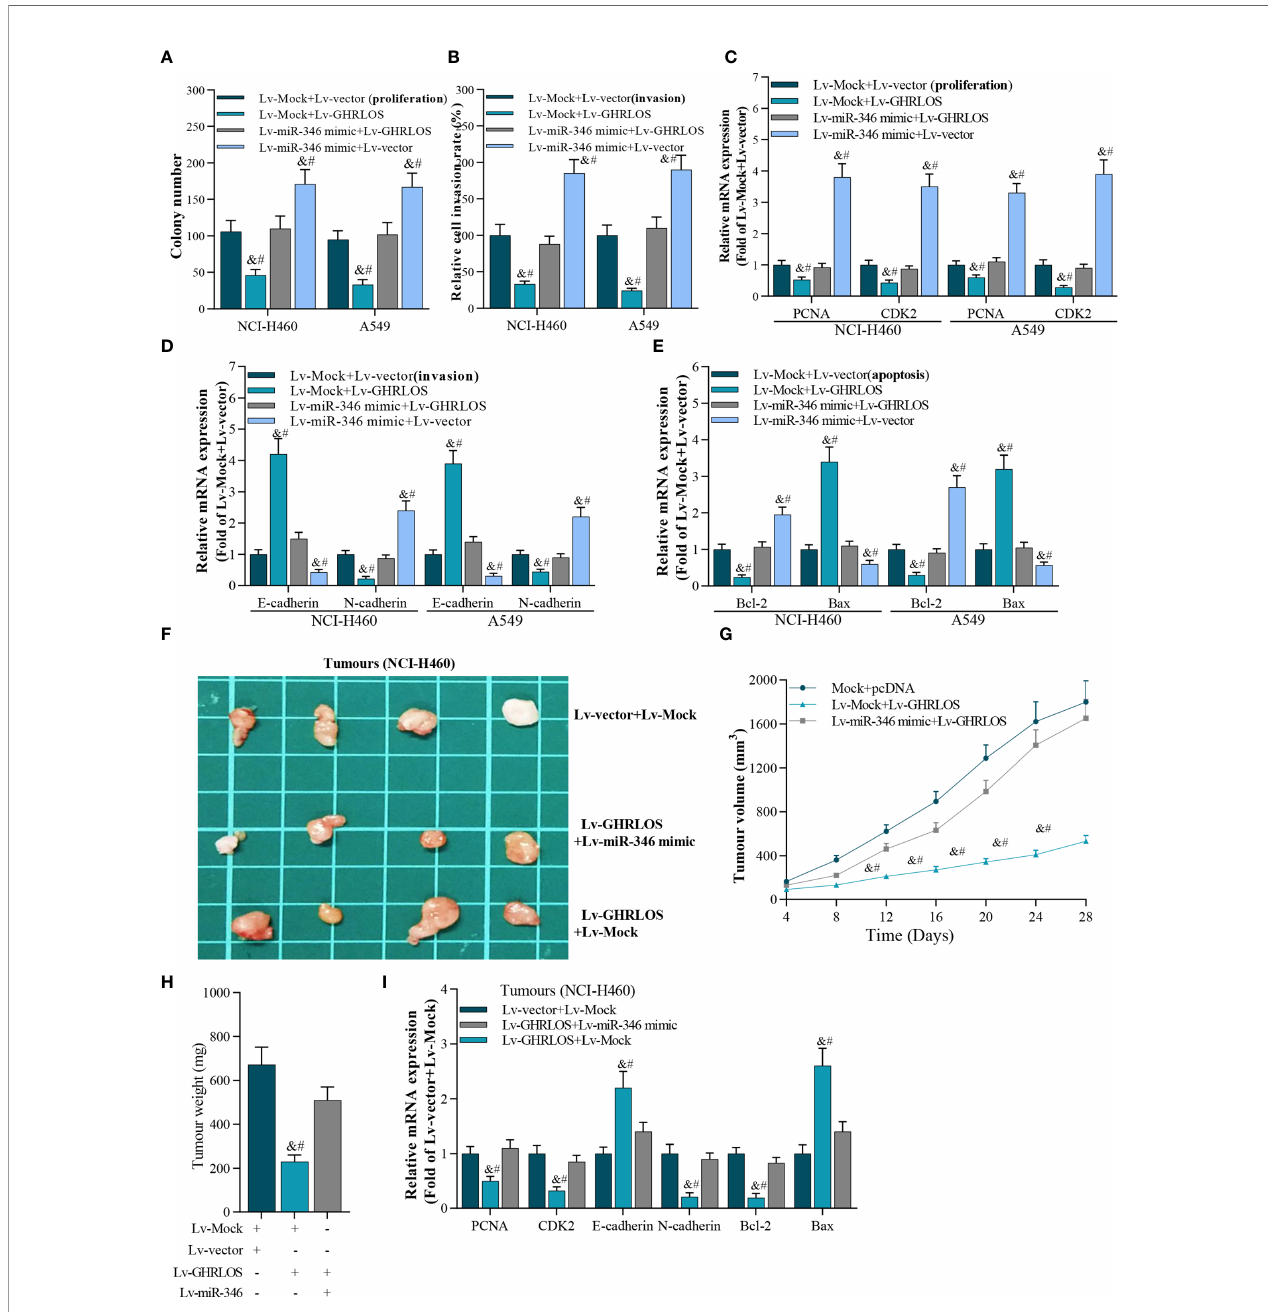
FIGURE 5 | The interaction between lncRNA GHRLOS and miR-346 in cancer cell proliferation, invasion, and apoptosis. (A) Colony formation assay showed reciprocal suppression between lncRNA GHRLOS and miR-346 on the growth of transfected cancer cells after 14 days culture, &p< 0.01 vs. Lv-Mock+Lv-vector, #p< 0.01 vs. Lv-miR-346+Lv-GHRLOS. (B) Trans-well assays on invasion of lentivirus infected cancer cells, &p< 0.01 vs. Lv-Mock+Lv-vector, #p< 0.01 vs. Lv-miR- 346+Lv-GHRLOS. (C) qRT-PCR on the expression of cell growth biomarkers, PCNA and CDK2, in A549 and NCI-H460 cells after infected with indicated lentivirus for 48 h, &p< 0.01 vs. Lv-Mock+Lv-vector, #p< 0.01 vs. Lv-miR-346+Lv-GHRLOS. (D) qRT-PCR on the expression of cell adhesion biomarkers, including E-cadherin and N-cadherin, in A549 and NCI-H460 cells, &p< 0.01 vs. Lv-Mock+Lv-vector, #p< 0.01 vs. Lv-miR-346+Lv-GHRLOS. (E) qRT-PCR analysis on the expression of cell apoptosis-associated genes, Bax and Bcl-2, in cancer cells after lentivirus infection for 48 h, &p< 0.01 vs. Lv-Mock+Lv-vector, #p< 0.01 vs. Lv-miR-346+Lv-GHRLOS. (F) Photo of tumors in nude mice after inoculation for 28 days. (G) The tumor volume of each group (n=6) measured at the indicated time points after inoculation of NCI-H460 cells. (H) The weight of tumors in nude mice after inoculation for 28 days, &p< 0.01 vs. Lv-Mock+Lv-vector, #p< 0.01 vs. Lv-miR-346+Lv-GHRLOS. (I) qRT-PCR analysis on the expression of PCNA, CDK2, E-cadherin, N-cadherin, Bcl-2, and Bax in xenografted tumors, &p< 0.01 vs. Lv-Mock+Lv-vector, #p< 0.01 vs.